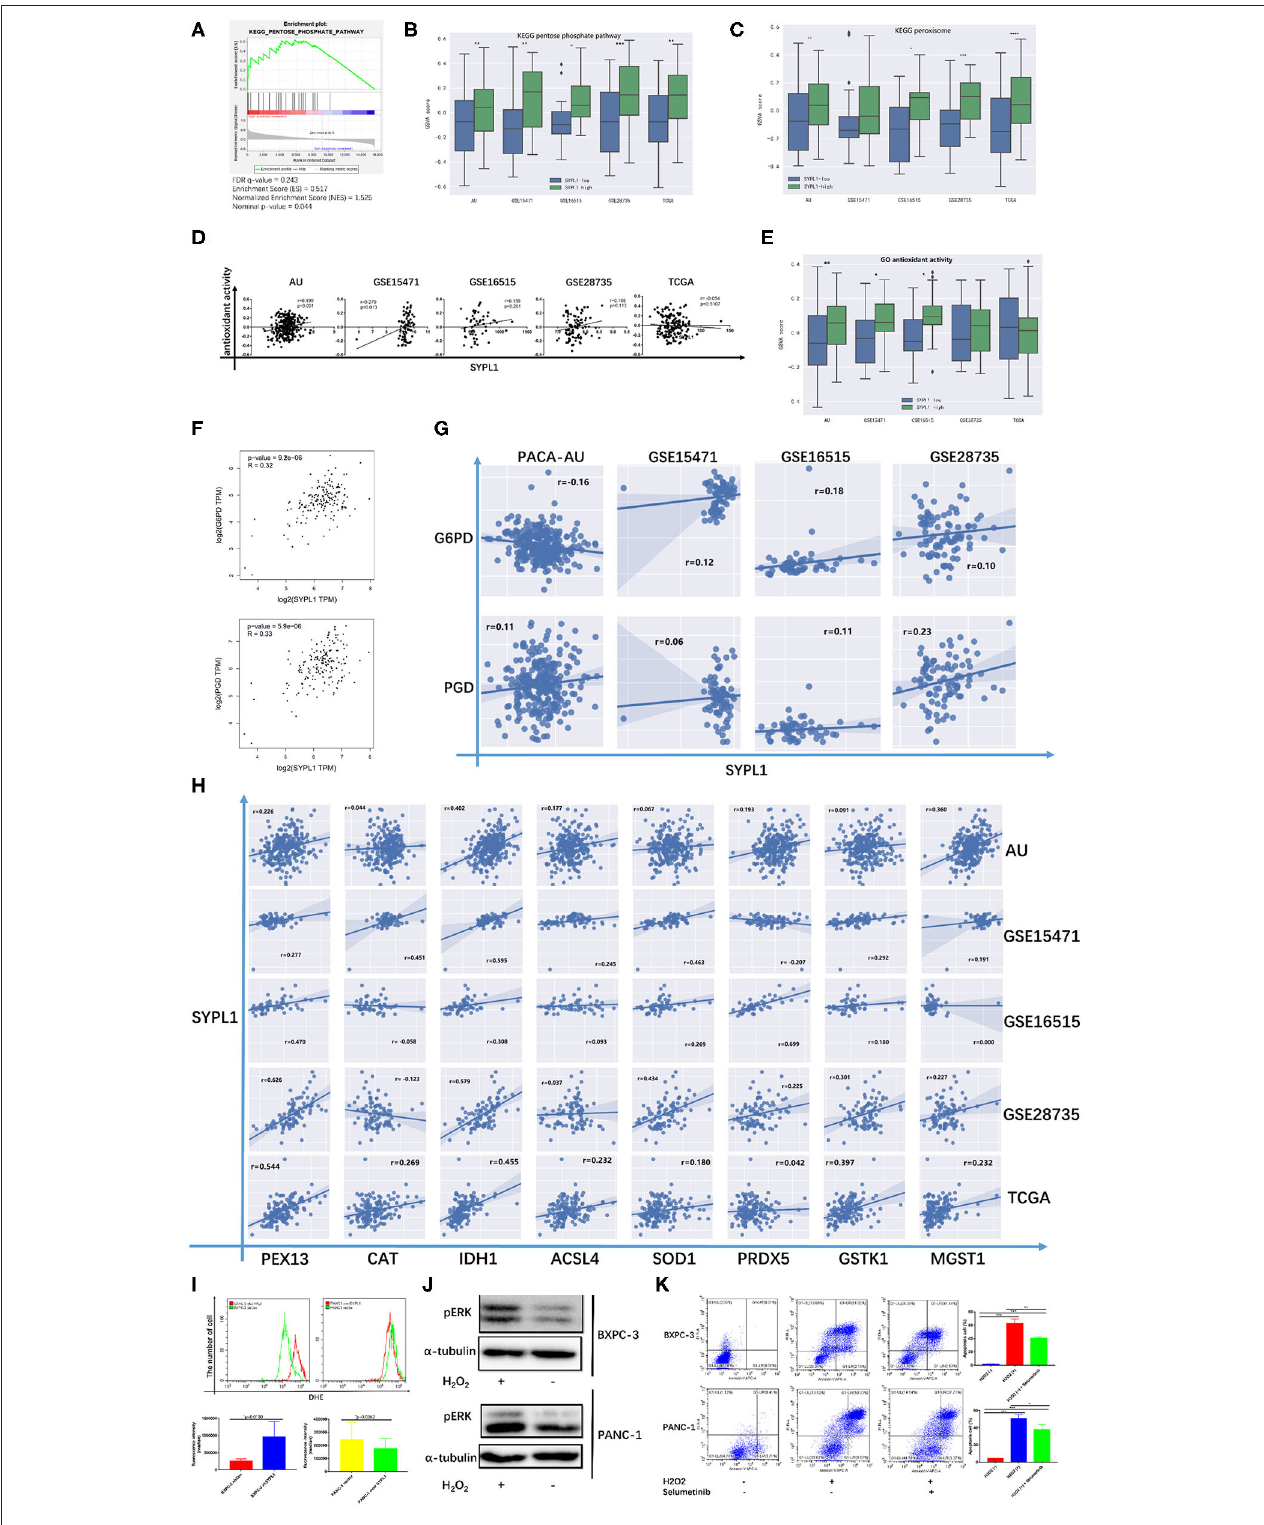
FIGURE 7 | Knockdown of SYPL1 activated ERK through elevation in ROS. (A) GSEA analysis showed that the expression of SYPL1 was related to the KEGG pentose phosphate pathway (PPP) in the TCGA dataset. (B) The GSVA score of the PPP gene set in SYPL1-high and SYPL1-low samples. (C) The GSVA score of the peroxisome gene set in SYPL1-high and SYPL1-low samples (Both tumor tissues and adjacent tumor tissues of GSE15471, GSE16515, and GSE28735 were taken